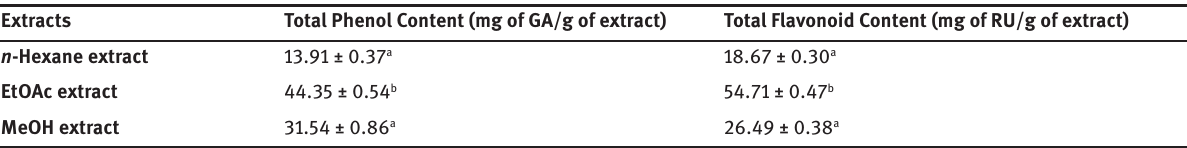
Values are expressed as mean ± SEM of three